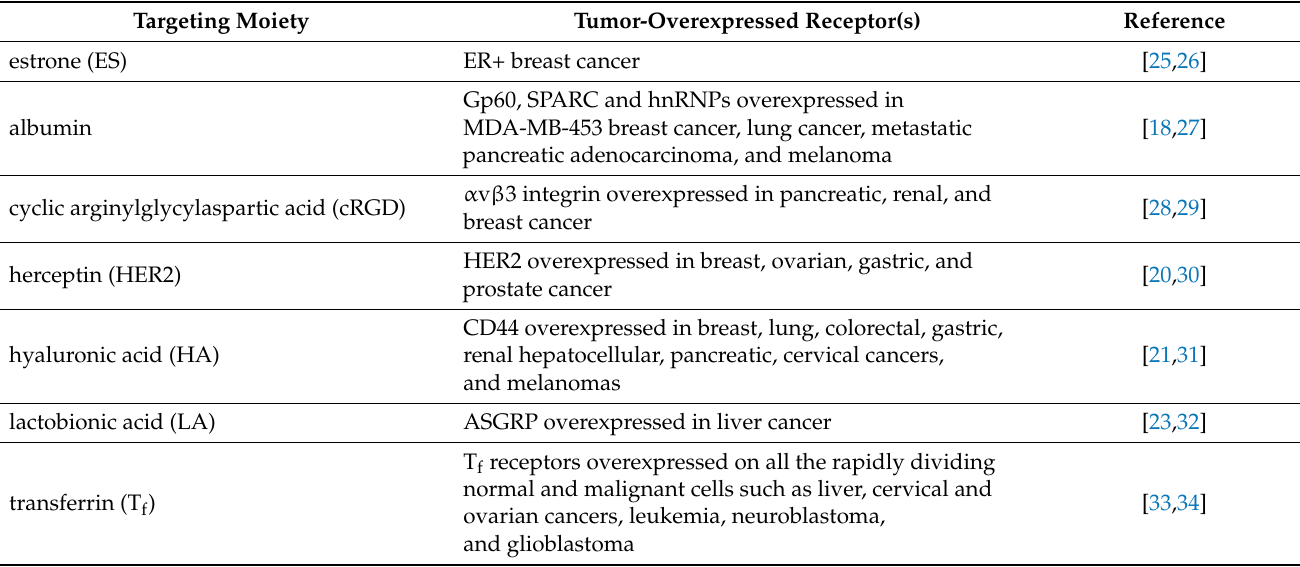
Table 2. Targeting moieties general